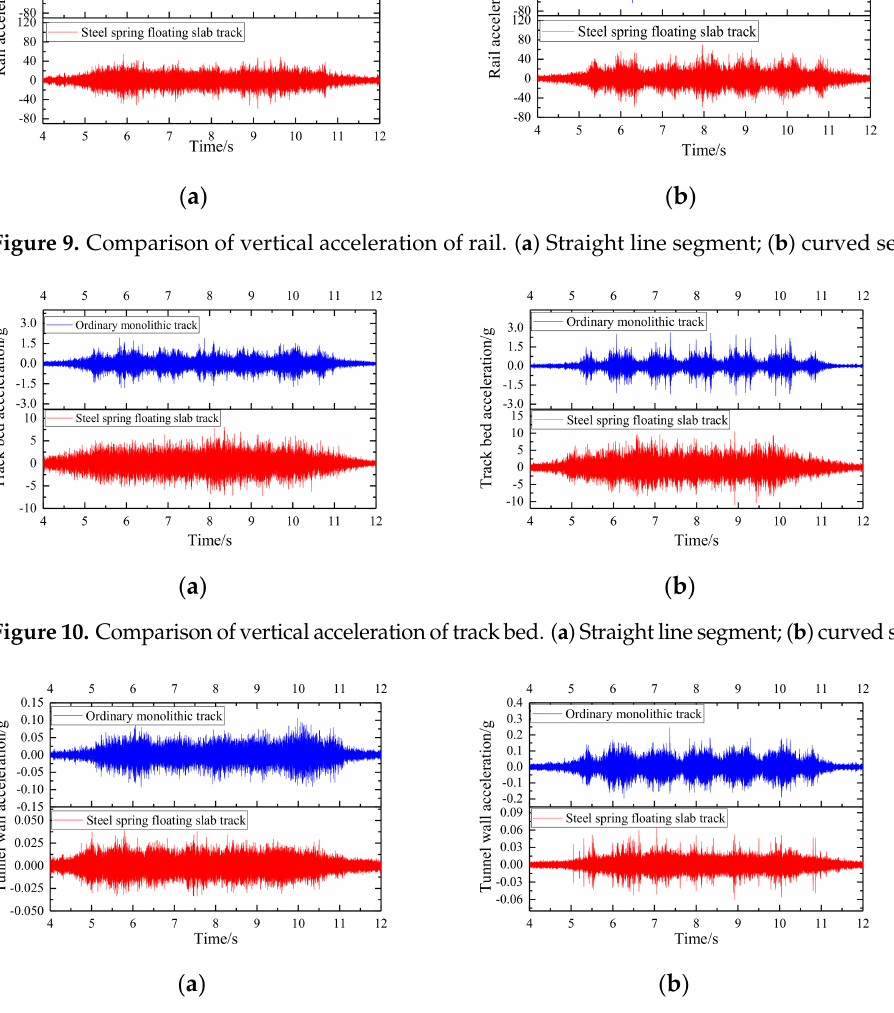
Figure 11. Comparisonofverticalaccelerationoftunnelwall. ( a )Straightlinesegment; ( b